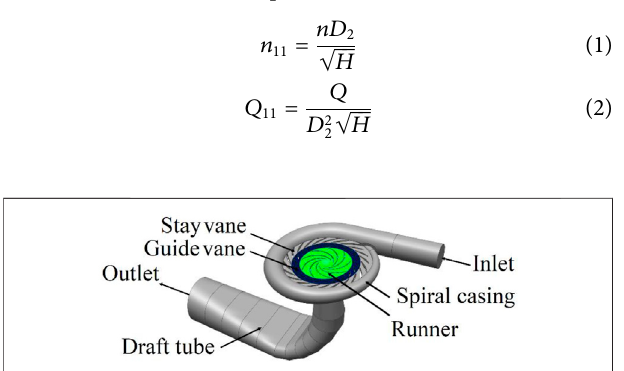
FIGURE 1 | Model pump